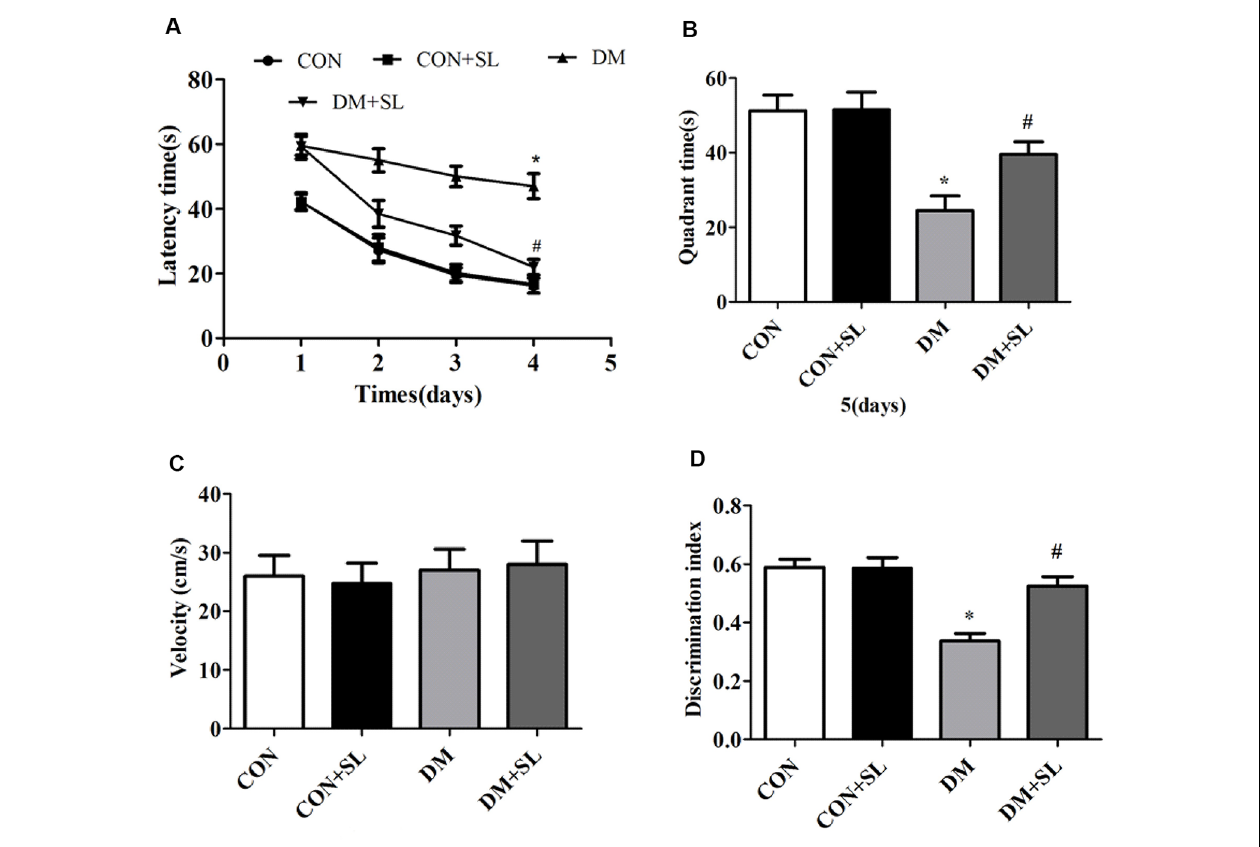
FIGURE 2 | Effect of strawberry leaf extract on learning and memory of rats with streptozotocin (STZ) induced diabetes determined by the Morris Water Maze (MWM) and new object recognition (NOR) tests. (A) The performance of the rats in the orientation navigation tests was evaluated by the average escape latency of four trials on each of four consecutive days. (B) Time spent swimming in the target quadrant in the probe test. (C) Swimming speed of all the animals. (D) Rats performance in the new object experiments, using the discrimination index to evaluate the cognitive ability. The data in each group are shown as mean ± SD, using repeated-measures ANOVA with post hoc Bonferroni tests to determine the statistical significance. * p < 0.05 vs. CON group; # p < 0.01 vs. DM group, n =